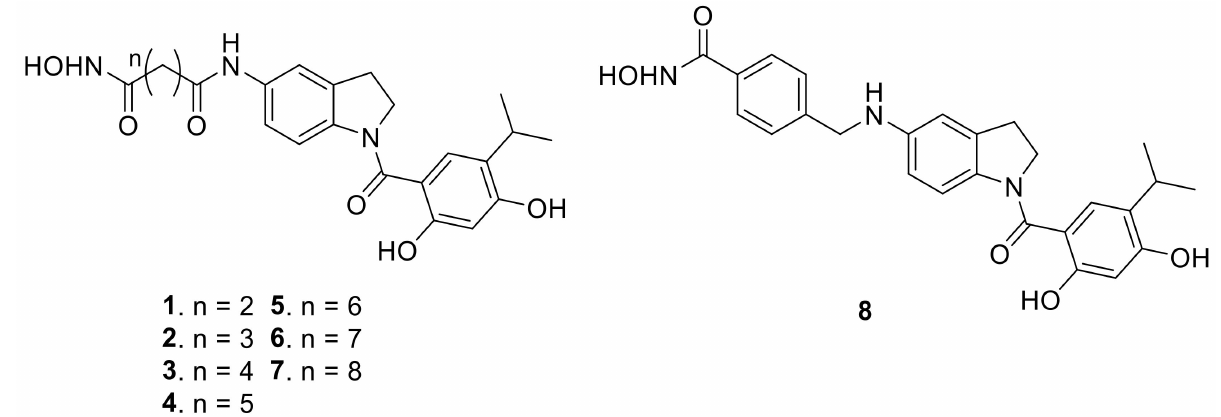
Figure 1. Structures of the designed